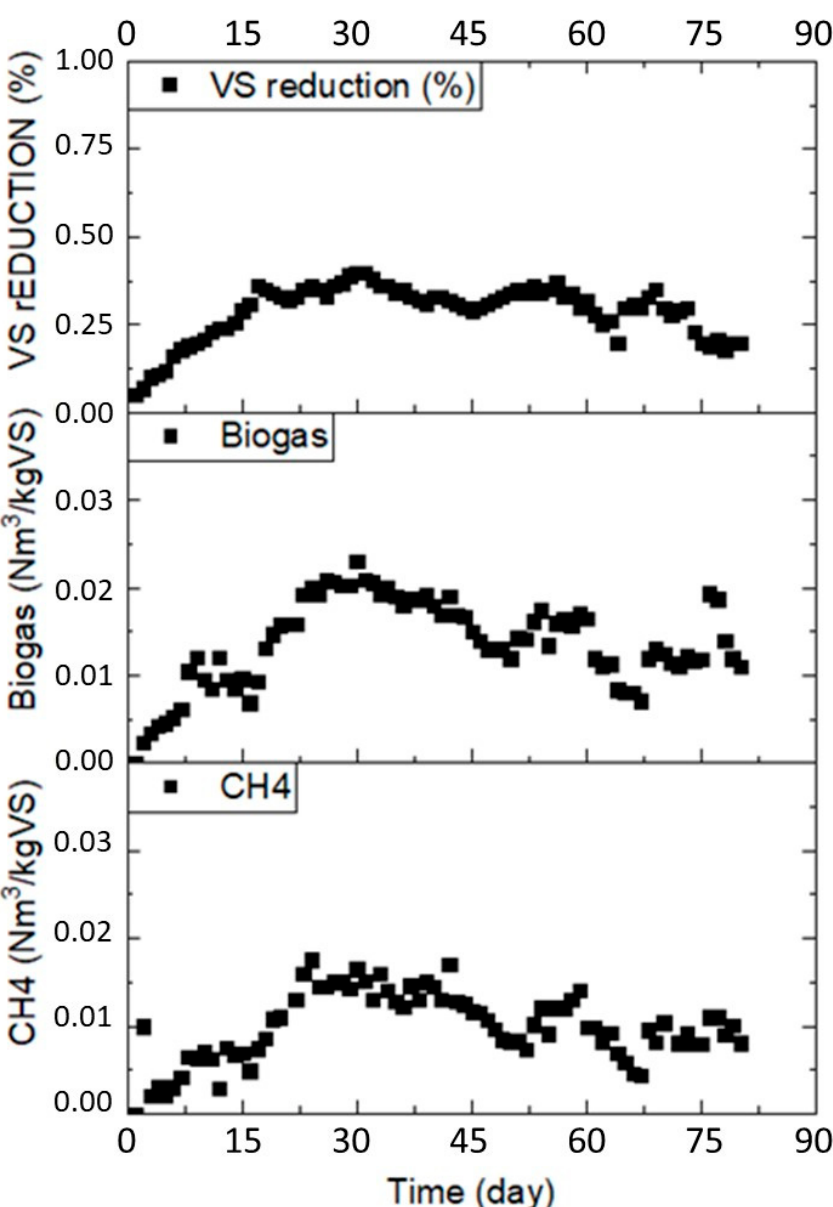
Figure 2. Performance of olive mill waste without any addition of heavy metals.